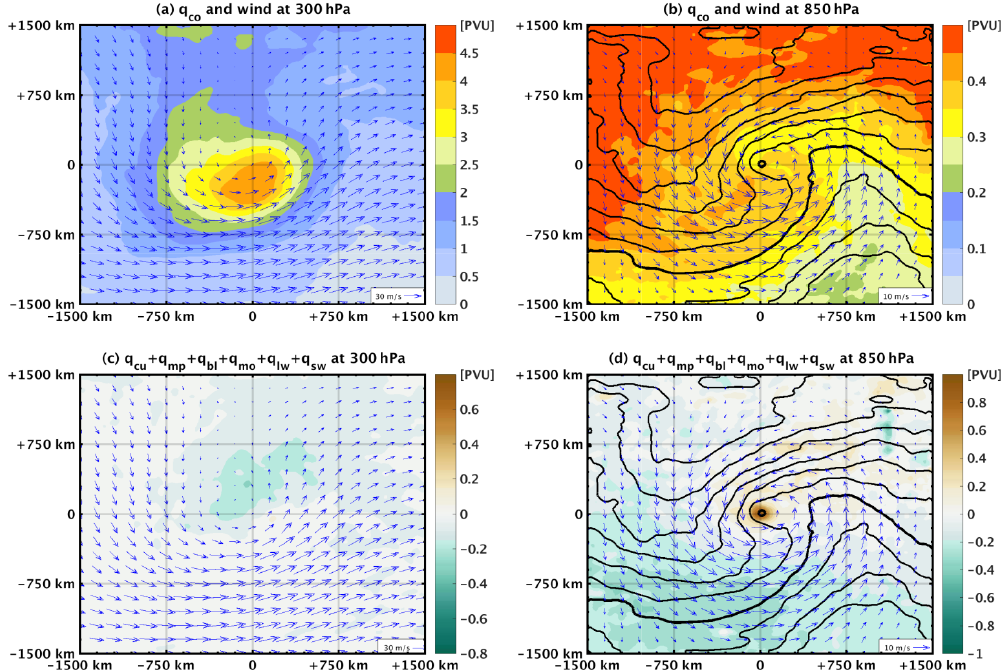
Figure 5. (a) Composite averages for all 100 cyclones at the time of their mature stage of q co (in colour) and wind (arrows) at 300hPa. (b) As in (a) but at 850hPa. (c) As in (a) but for the sum of all non-conserved PV tracers. (d) As in (b) but for the sum of all non-conserved PV tracers. Note that the value ranges in the colour bars differ among panels. As a guide to the location of fronts, the composite average of equivalent potential temperature ( θ e ) at 850hPa is also shown in panels (b) and (d) (black contours, every 2K, bold for